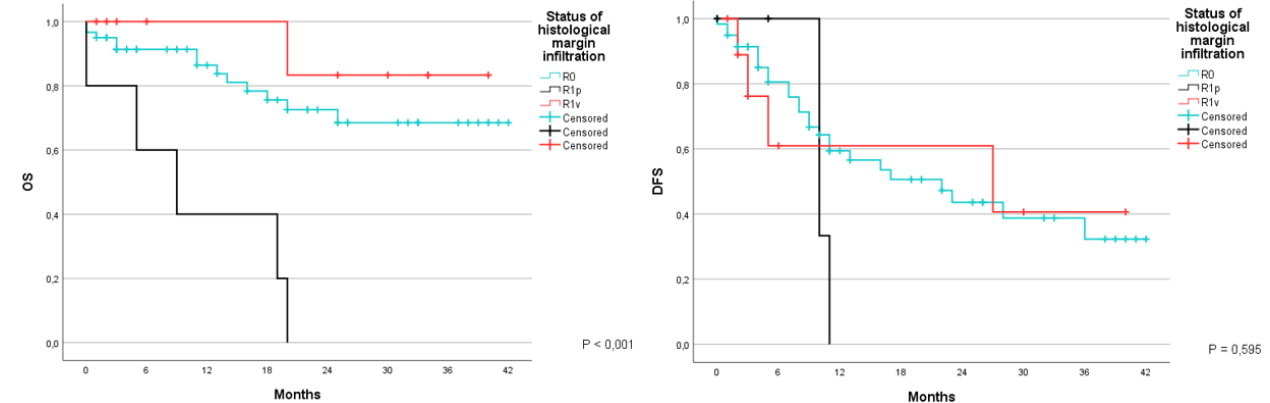
Figure 11. Kaplan-Meier Curve for OS and DFS in patients who underwent liver resection for CRLM stratified according to the status of histological margin infiltration. OS: Overall Survival; DFS: Disease Free Survival; CRLM: Colorectal liver metastasis; R1p: parenchymal R1; R1v: vascular R1.